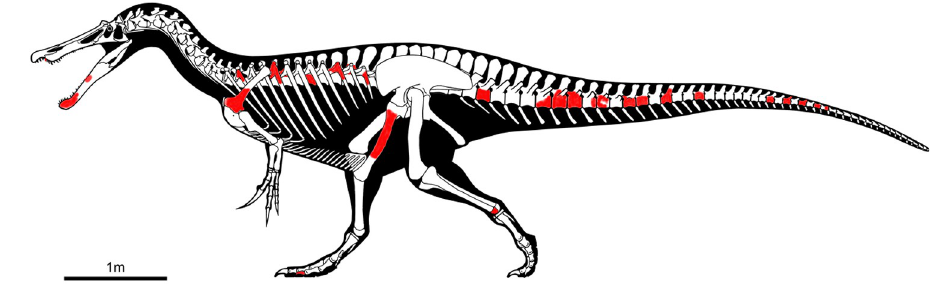
Fig 2. Skeletal diagram showing in red the recovered elements of ML1190 ( Iberospinus natarioi ) at Praia de Aguncheiras. Courtesy of Scott Hartman.